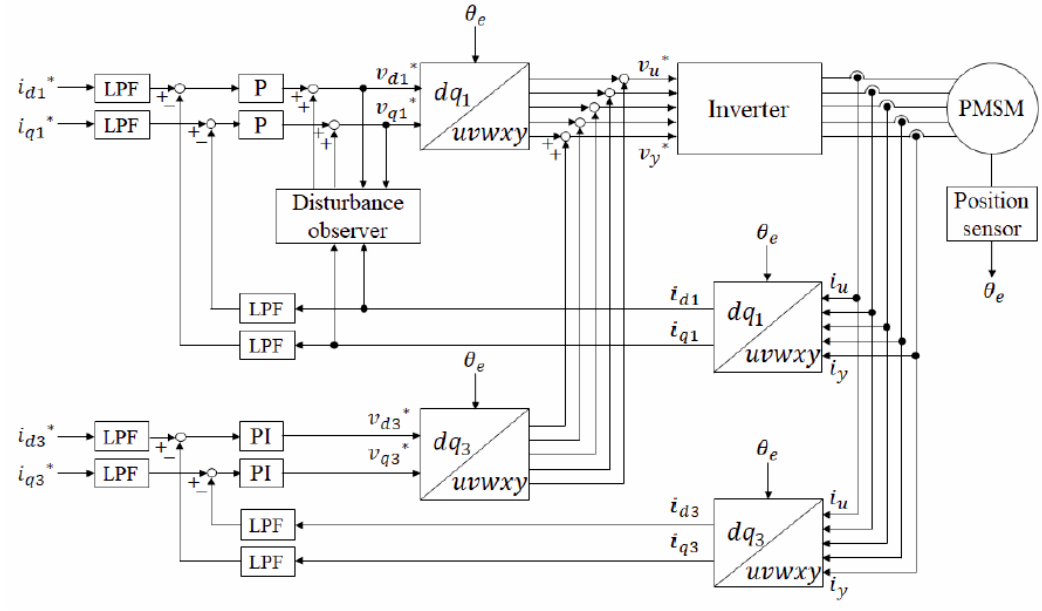
Figure 11. Block diagram of current control.